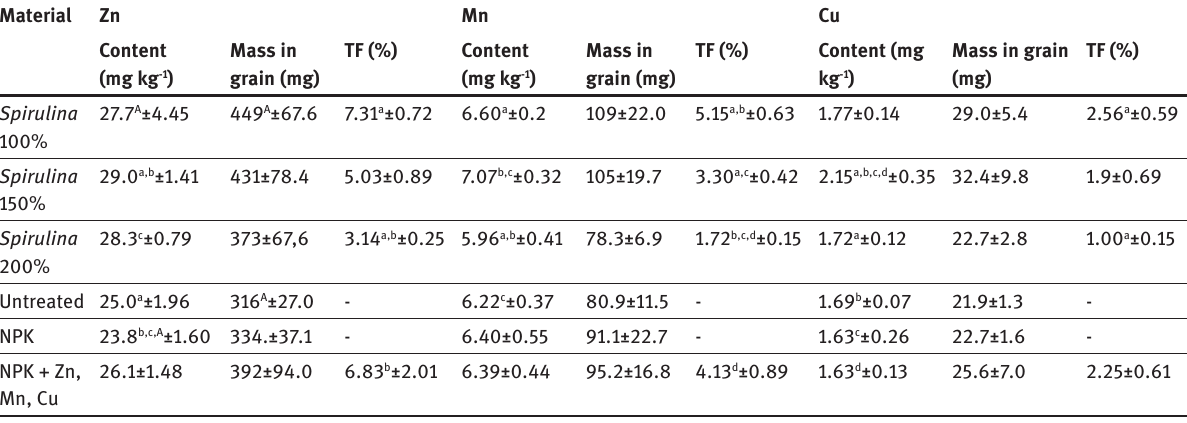
Table 5: Multielemental analysis of maize grain.